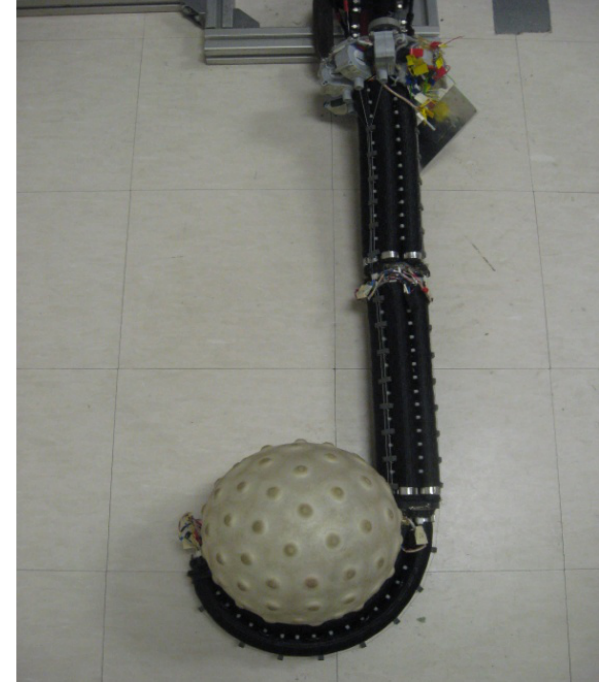
Figure 5. Octarm grasping a spherical object – continuum